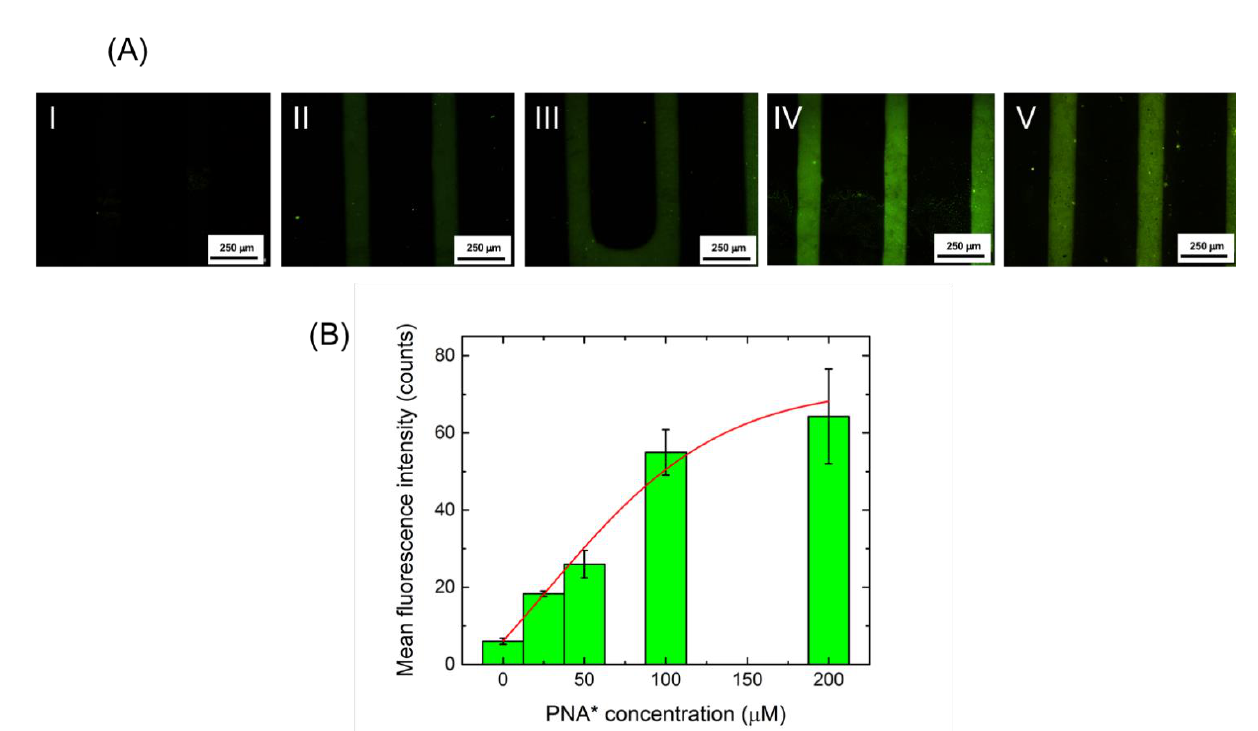
Figure 5. ( A ) Fluorescence microscopy imaging of ZnONW-based device before PNA immobilization (I) and after func- tionalization with 25 µM PNA* (II), 50 µM PNA* (III), 100 µM PNA* (IV), and 200 µM PNA* (V). ( B ) Mean fluorescence intensity of the device after functionalization with PNA* at different concentrations. Data were fitted using a dose-response curve (red line).